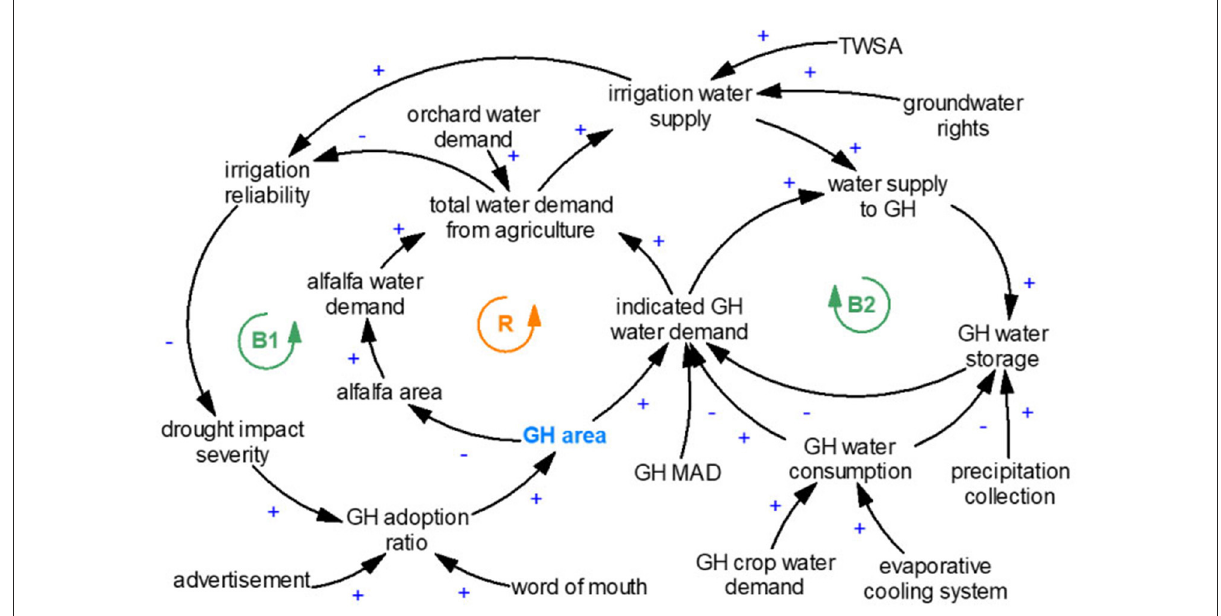
FIGURE4 Causal loop diagram for greenhouse system within irrigation water demand and supply structure. B denotes balancing loop; R denotes reinforcing